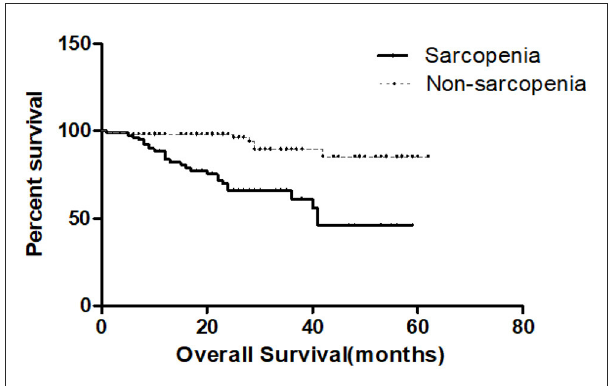
FIGURE1 Kaplan-Meier survival plot for all subjects.